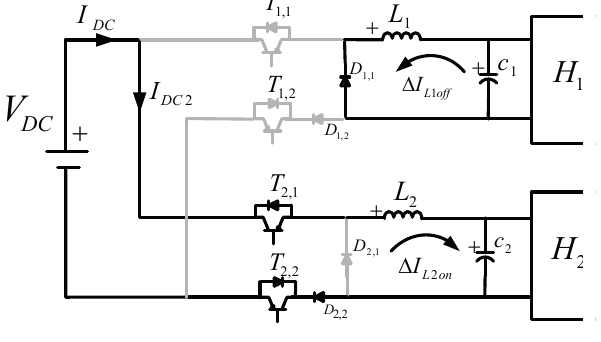
Figure 3. Topological state (iii), m 1 = 1, m 2 =